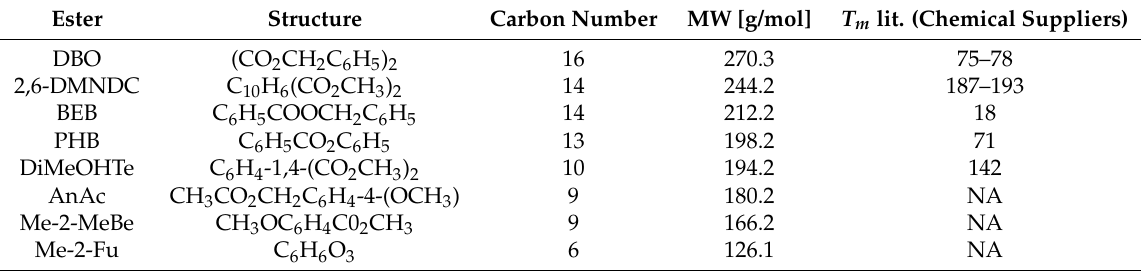
Table 3. Summary of the literature values on the phase change temperatures of the commercial aromatic esters investigated. Missing data are indicated as Not Available (NA). No information on the enthalpies or degradation temperatures have been found, therefore it is not